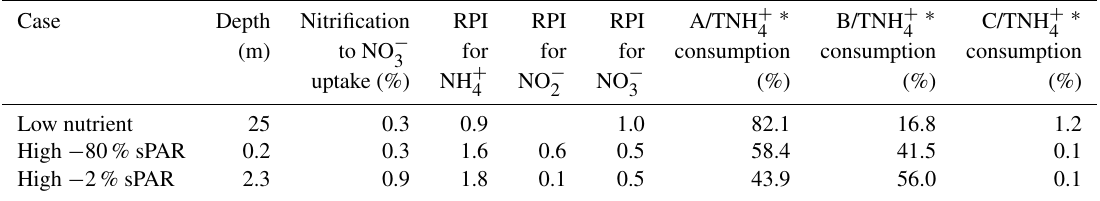
consumption in low- and high-nutrient cases. 4